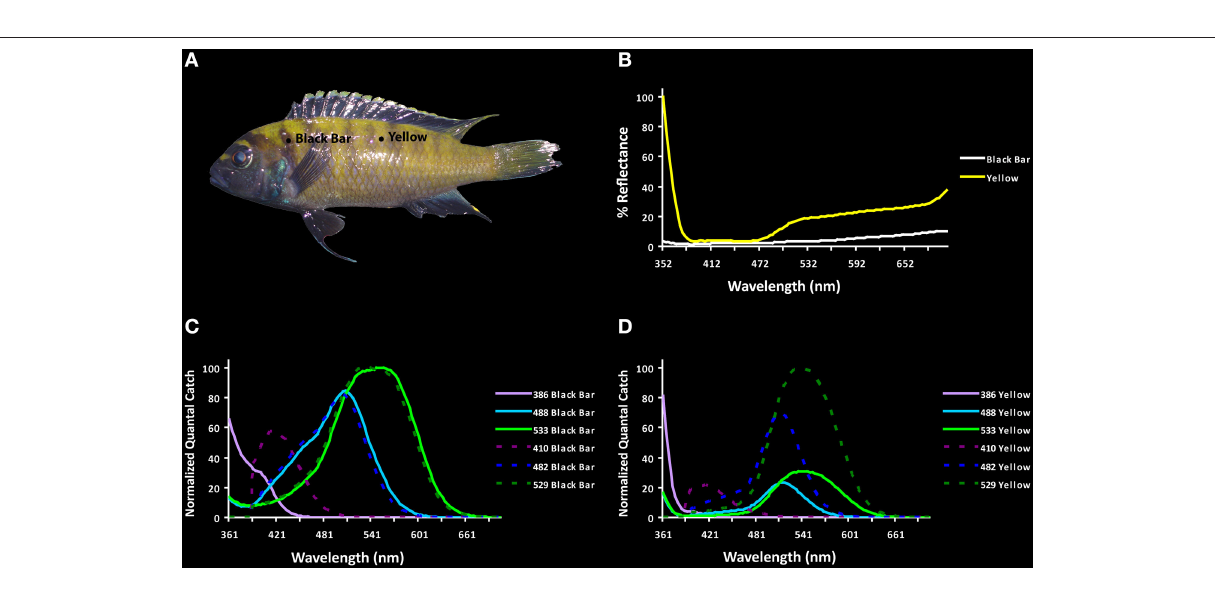
FIGURE 7 | Pseudotropheus flavus